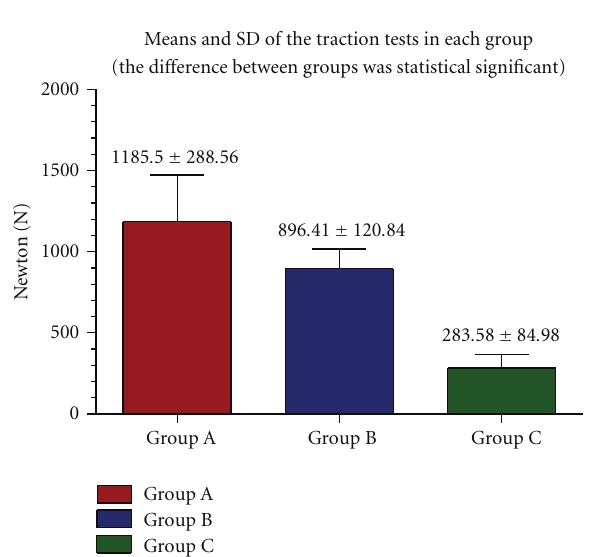
Figure 6: Mean and SD of the number of fissures in groups A and B. Figure 7: Mean and SD of traction tests in each